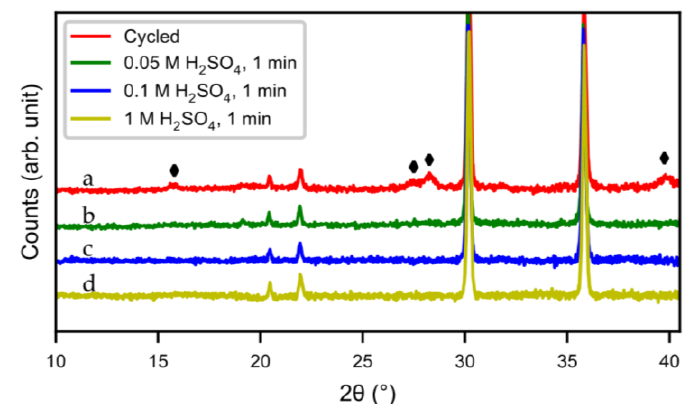
Figure 12. XRD patterns of acid-treated samples, ( a ) untreated, ( b ) 0.05 M H 2 SO 4 for 1 min, ( c ) 0.1 M H 2 SO 4 for 1 min, ( d ) 1 M H 2 SO 4 for 1 min. ( (cid:7) ) RE(OH) 3 . Molecules 2020 , 25 , x